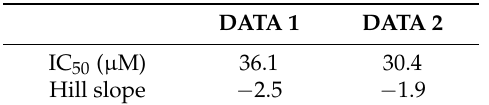
Table 2. Values for the half maximal inhibitory concentration (IC 50 ) and the Hill slope of amentoflavone, as obtained using AlphaScreen † against the bromodomain 4 (BRD4)